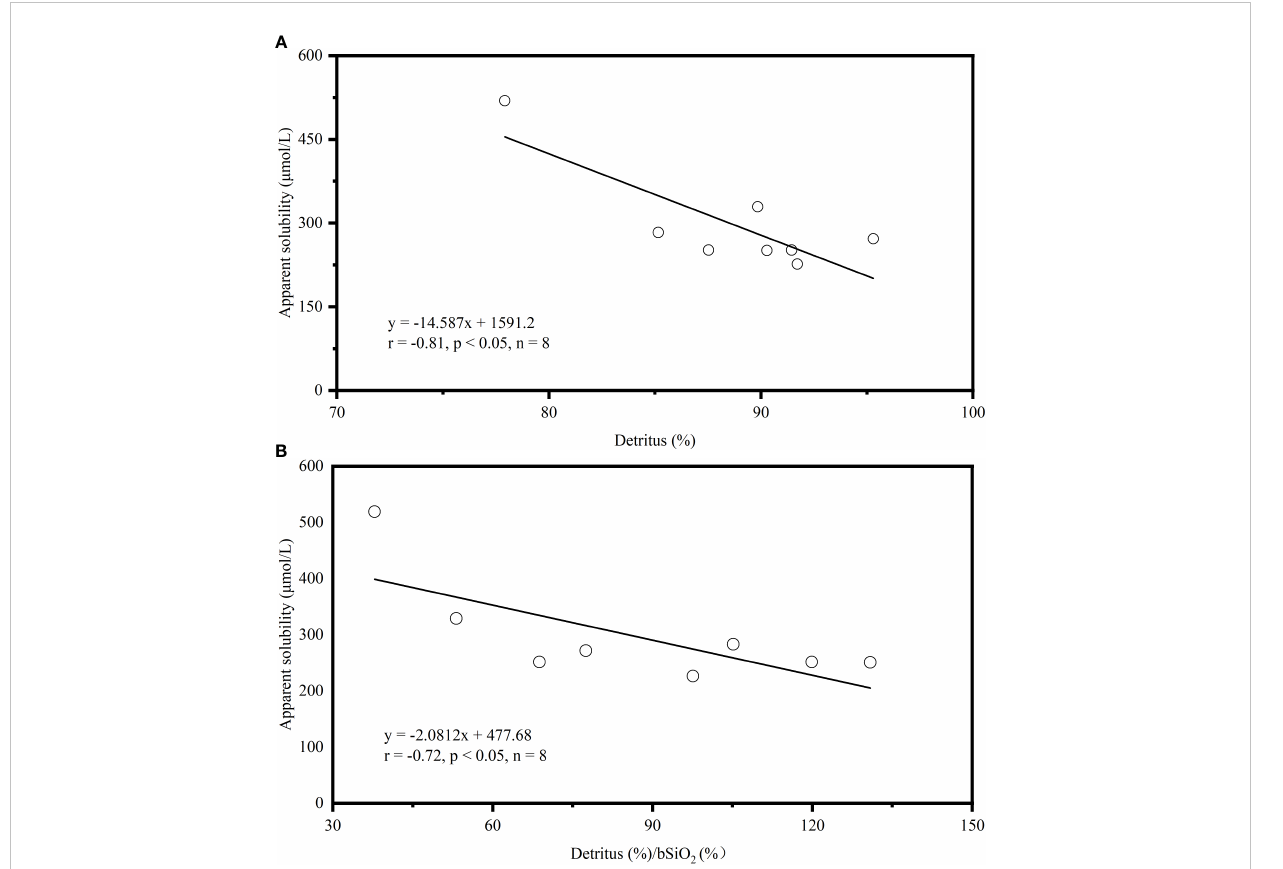
FIGURE 9 Correlations between (A) bSiO 2 apparent solubility ( m mol/L) and detrital material content (%), and (B) bSiO 2 apparent solubility ( m mol/L) and detrital material (%)/bSiO 2 (%) in sediments of the NSCS. The Pearson correlation coef fi cients (r) and regression curves are